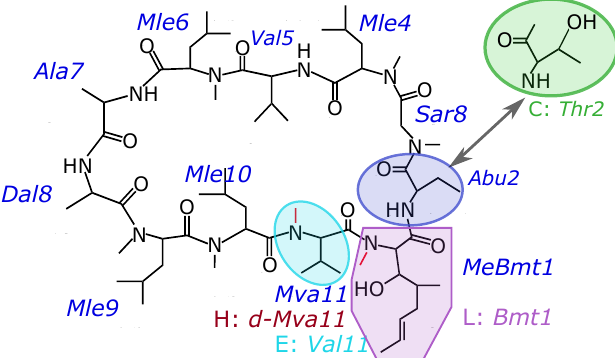
Figure 1. Chemical formulas of the studied variants of cyclosporins. Samples for NMR experiments contained ∼ 1 mg peptide, giving the final concentration of about 1 mM, and 7–9 mg dodecylphosphocholine. Cyclosporin H was purchased from Cayman Chemicals; other peptides, from AvaChem Scientific; DPC, from Avanti Polar Lipids. Powders were mixed and dissolved in water. A mixture of 90% H 2 O and 10% D 2 O was used to observe amide proton signals, which exchange with the solvent within minutes; pure D 2 O (Solvex-D) was used for better quality of the H α spectral region. A clear solution was obtained after stirring and sonication. The resulting concentration exceeds the critical micelle concentration for DPC (1 mM); furthermore, NOESY spectra demonstrated negative nuclear Overhauser effect and strong cross-peaks, which is the indication of the low mobility of the observed molecules, with the correlation time τ obeying the inequality τω (cid:29) 1 for the spectrometer frequency ω = 4.4 × 10 9 rad/s. Note that in solvents such as chloroform or DMSO cyclosporin exhibits small and positive or small and